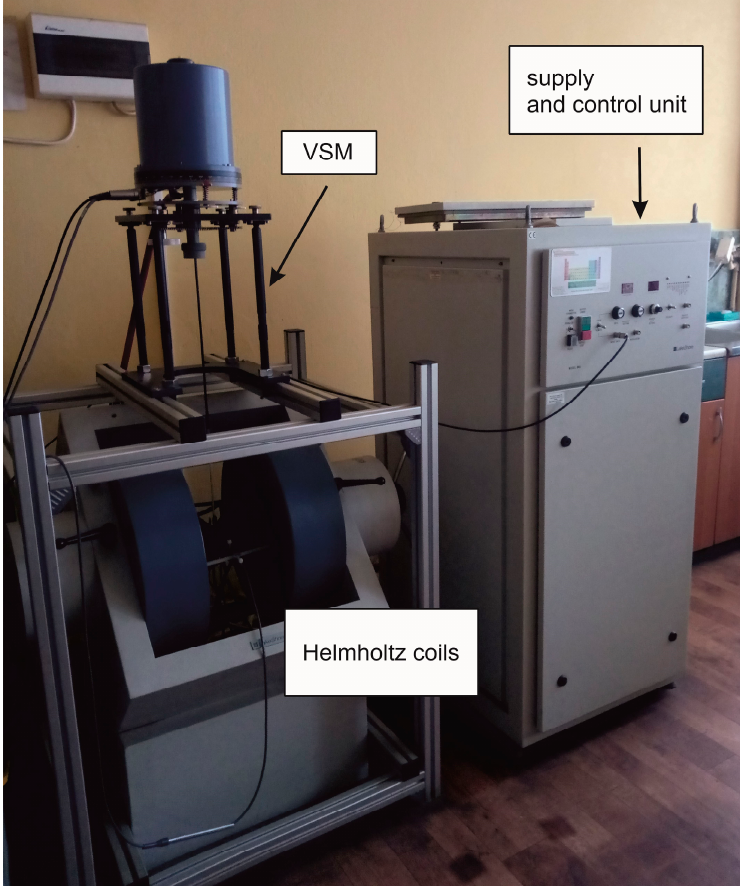
Figure 3. The measurement setup at the Chair of Physics, Cz ę stochowa University of Technology. VSM—Vibrating Sample Magnetometer.